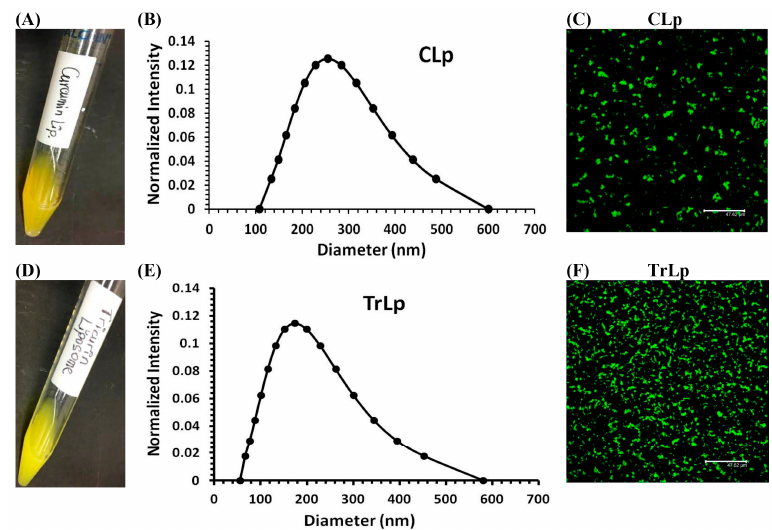
Figure 1. Physical Characterization of CLp and TrLp particles. ( A , D ) CLp (5 mM) and TrLp (1.28 mM+) exhibited a light-yellow, stable emulsion with no noticeable precipitation upon long-term standing; ( B , E ) Based on DLS analysis, the median hydrodynamic diameters were ~260 nm. ( n = 3) for CLp and ~200 nm for TrLp; ( C , F ) Confocal laser scanning at 540 nm (C’s emission maximum) revealed spherical CLp and TrLp particles.